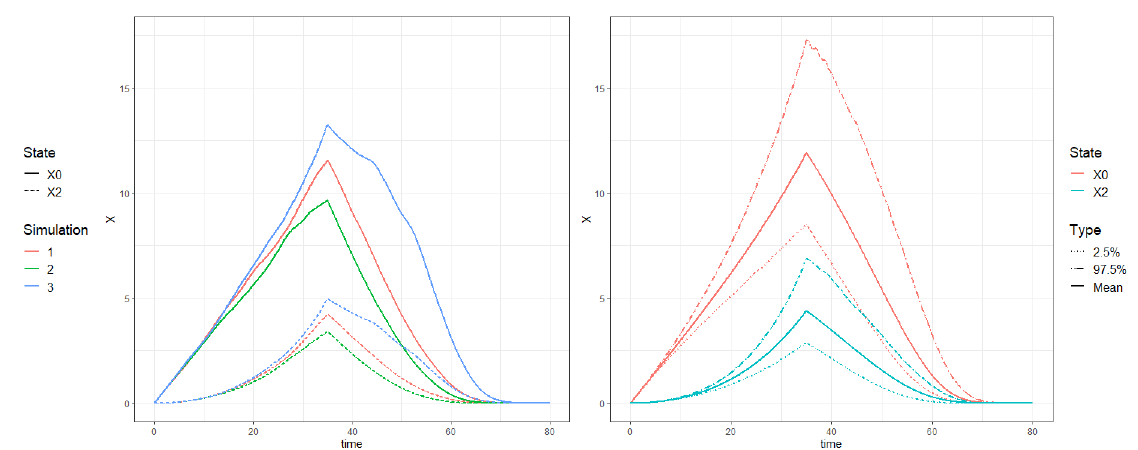
Figure 4. Left : State-wise projections of the savings account in the three simulated scenarios of the interest rate. Right : The mean and confidence intervals of the projected savings